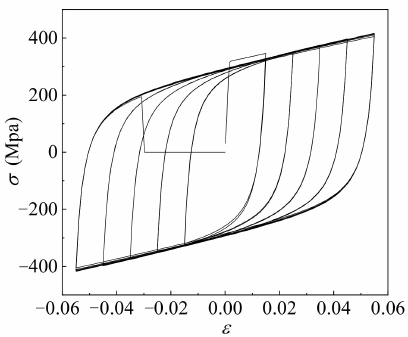
Figure 7. The stress–strain relationship of the steel